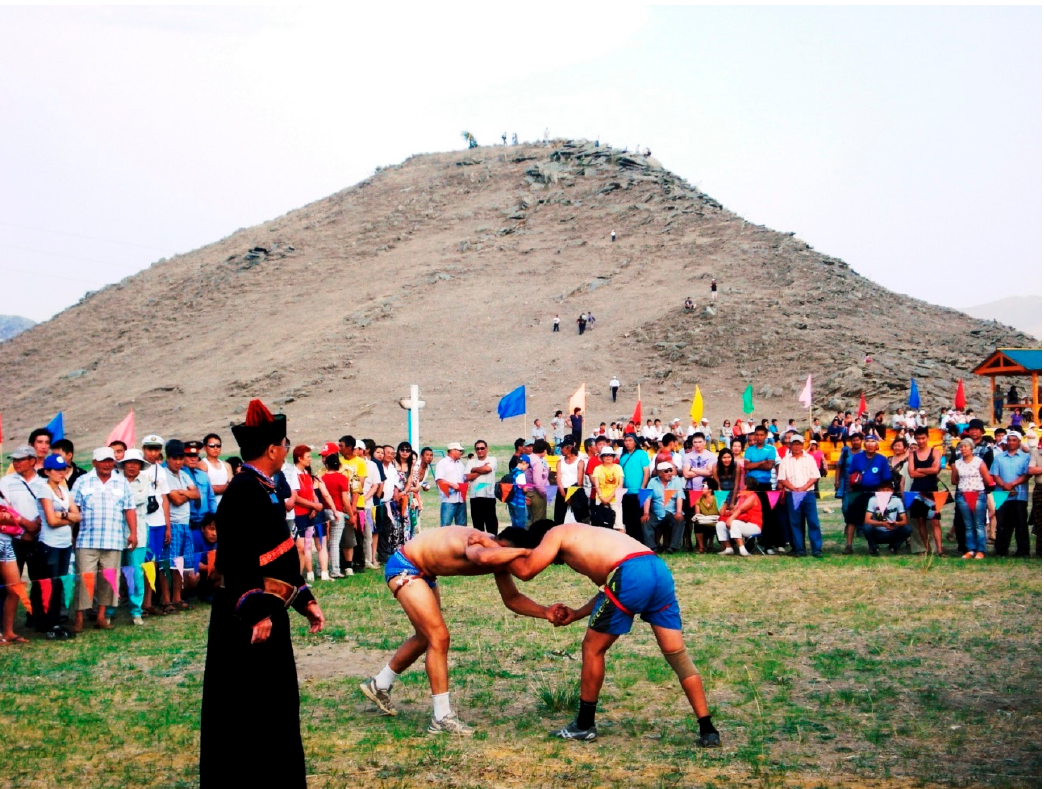
Figure 11. Wrestlers at the foot of the hill “Yord” at the “Games of the Yord” of 2011. Photo: Stefan Krist.